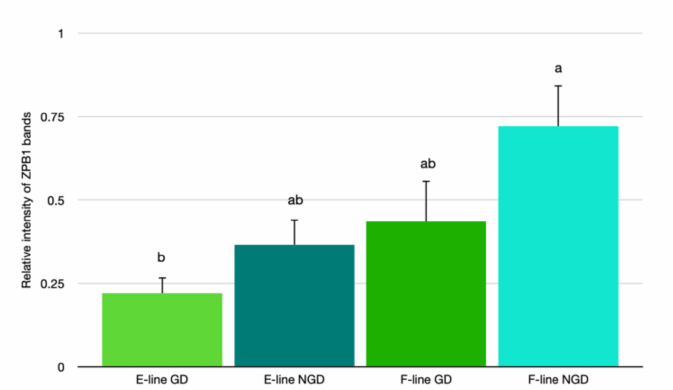
Figure 5. Relative abundance of ZPB1 protein in the perivitelline layer of laid eggs between ( A ) the non-germinal disc (NGD) region and germinal disc (GD) region with a representative blot for ZPB1 comparing GD and NGD regions and section of total protein used for normalization. ( B ) Relative abundance of ZPB1 in the perivitelline layer of laid eggs between two genetic lines of turkey hens selected for either egg production (E-line) or rapid body growth (F-line) along with a representative blot for ZPB1 and total protein. For ( A ), n = 12 replicate samples per perivitelline location (6 E-line eggs plus 6 F-line eggs), and for ( B ), n = 12 replicate samples (6 GD plus 6 NGD) per genetic line. Values represent the mean ± SEM. * indicates significant difference in means, p < 0.05.